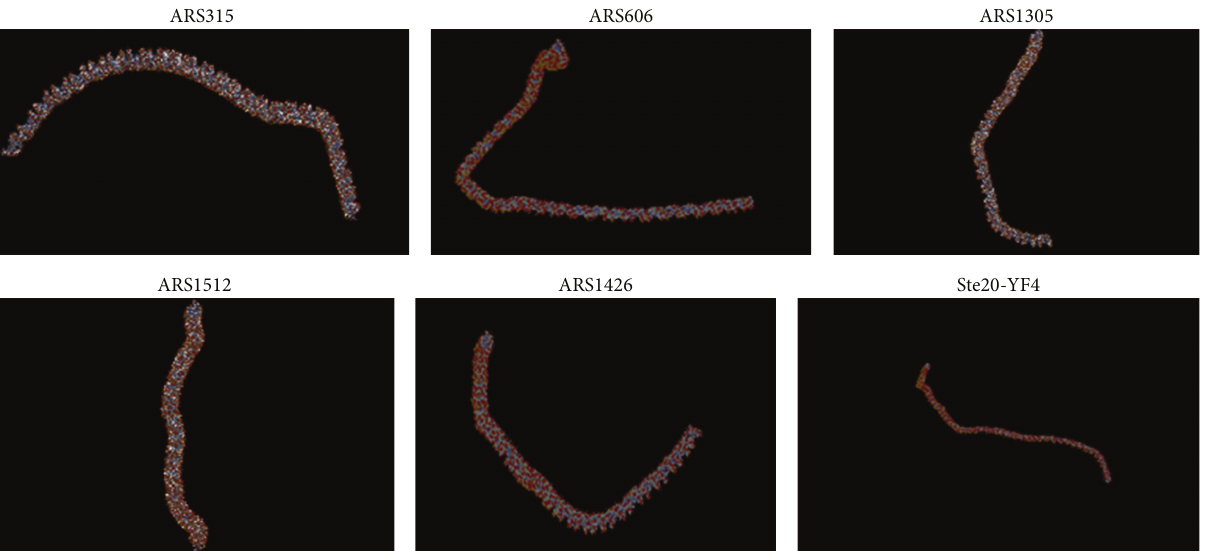
Figure 9: Three-dimensional view of the amplification promoting sequences. The figures show the 3D structure of the APS depicting the inbuilt curvature in the DNA sequences. These were made using the model.it